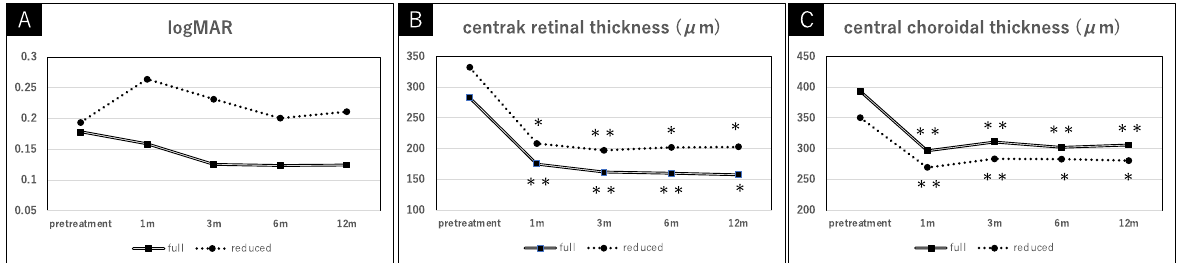
Figure 1. The serial changes in the logMAR ( A ), central retinal thickness ( B ), and central choroidal thickness ( C ) mean during the 1-year follow-up after the combination therapy in pachychoroid neovasculopathy. After treatment, there were statistical differences in the central retinal thickness and the central choroidal thickness at each time period, compared to before treatment. Data are expressed as mean and standard error bar and * p < 0.01.